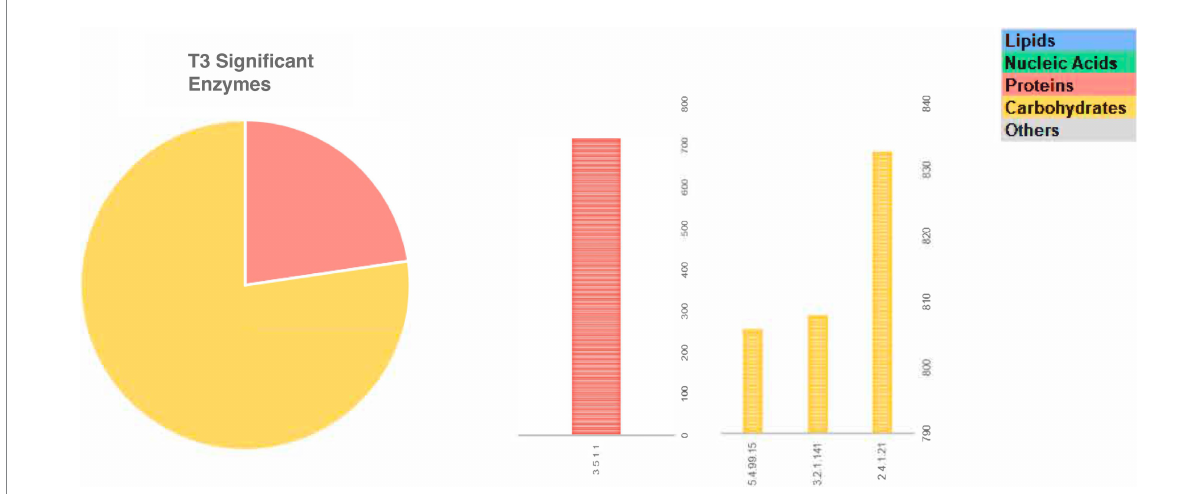
FIGURE 4 Significant enzyme-coding genes with greater abundance at different fermentation points (a – T1 and T2; b – T3), which were involved in the metabolism of lipids, carbohydrates, proteins, nucleic acids, micromolecules and others in fine cocoa beans